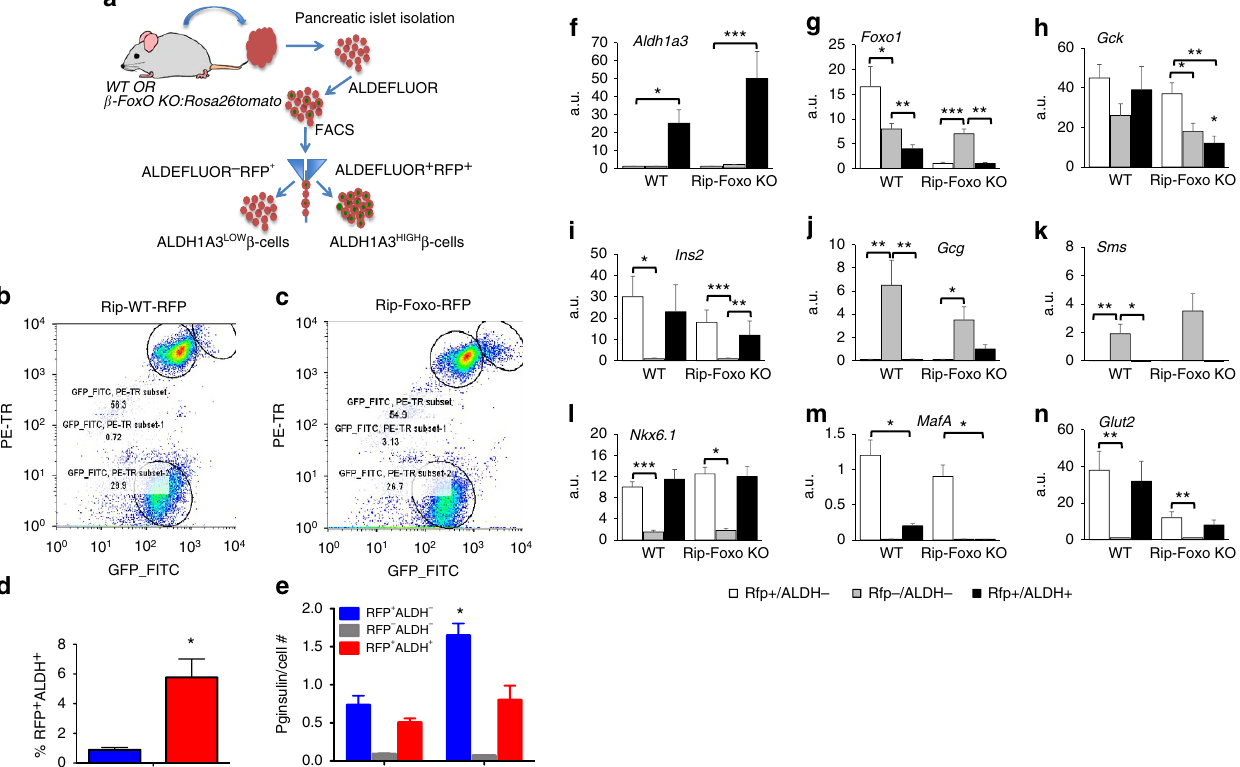
Figure 4 | Isolation and characterization of ALDH þ cells. ( a ) Enrichment procedure to isolate ALDH-expressing islet cells. b cells are labelled red by Rip-cre-activated Tomato. Cells are incubated with aldefluor, and selected for tomato and aldefluor, yielding ALDH (cid:3) (low) and ALDH þ (high) cells. ( b , c ) Experimental validation. Islets from 6-month-old b -cell-specific (Rip-cre) Foxo knockouts and littermate controls were sorted as described. The different circles denote the three cell populations used in further studies: RFP (cid:3) ALDH (cid:3) , RFP þ ALDH (cid:3) and RFP þ ALDH þ . ( d ) Quantification of RFP þ ALDH þ cells in repeated sorts ( n ¼ 5) of wild-type and Rip-Foxo knockout animals. ( e ), Insulin secretion in RFP (cid:3) ALDH (cid:3) (GFP_FITC, PE TR subset 2), RFP þ ALDH (cid:3) (GFP_FITC, PE TR subset), and RFP þ ALDH þ (GFP_FITC, PE TR subset 1) cells isolated from wild-type mice ( n ¼ 3). ( f – n ) Quantitative PCR analysis of selected transcripts in the different fractions isolated from islet cell preparations. One asterisk indicates P o 0.05 by one-way ANOVA. Error bars indicate